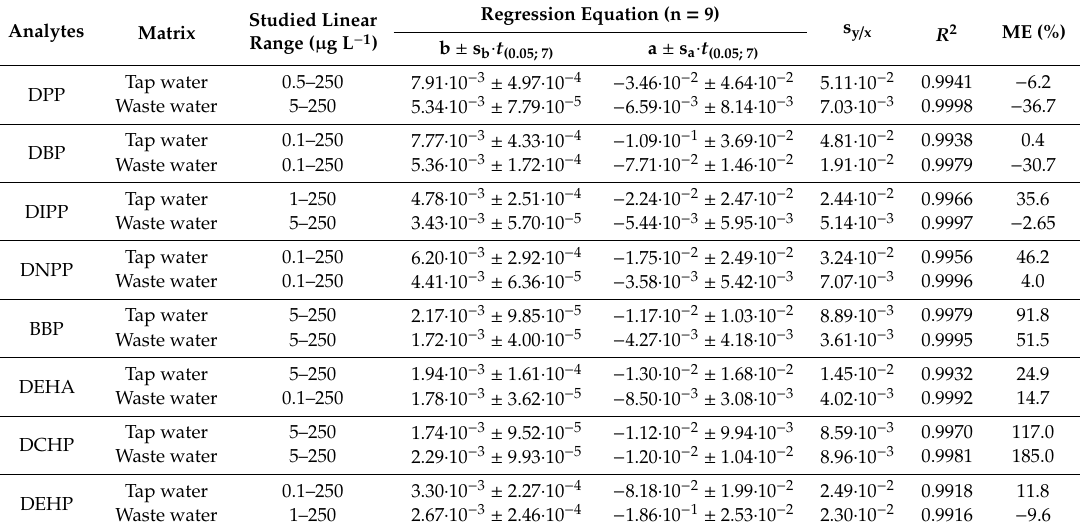
Table 1. Matrix-matched calibration data and matrix e ff ect percentage of the target analytes.